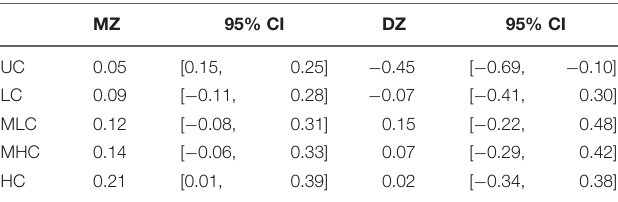
TABLE 2 | Within-pair intraclass correlations and 95% credible intervals for decision scores in Study